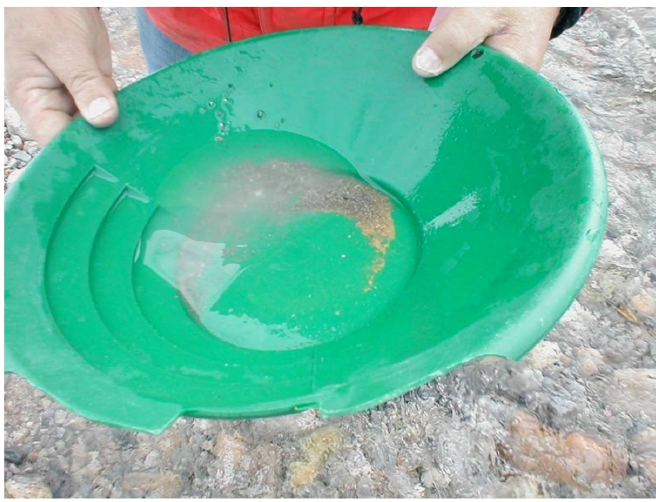
Figure 1. Liberated gold panned directly from a drive floor sample.